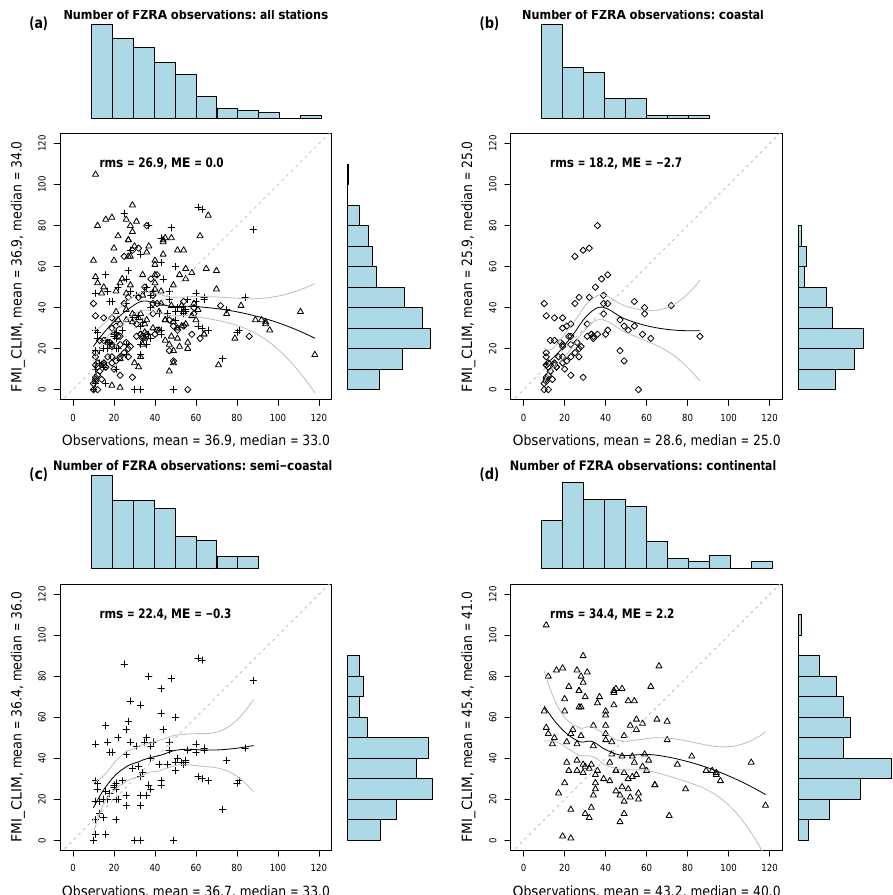
Figure 5. The total number of FZRA events according to the observations compared with the number of FZRA events according to FMI CLIM for stations in the calibration set, using (a) all 293 stations and stations in (b) coastal, (c) semi-coastal, and (d) continental groups. The curves superimposed in the scatter plots show FMI CLIM as the function of observations using the loess method (Venables and Ripley, 2002) together with the 95% confidence interval. Note that plotting symbols for groups in (b) , (c) , and (d) are used also in (a) . The bar diagrams present relative frequency